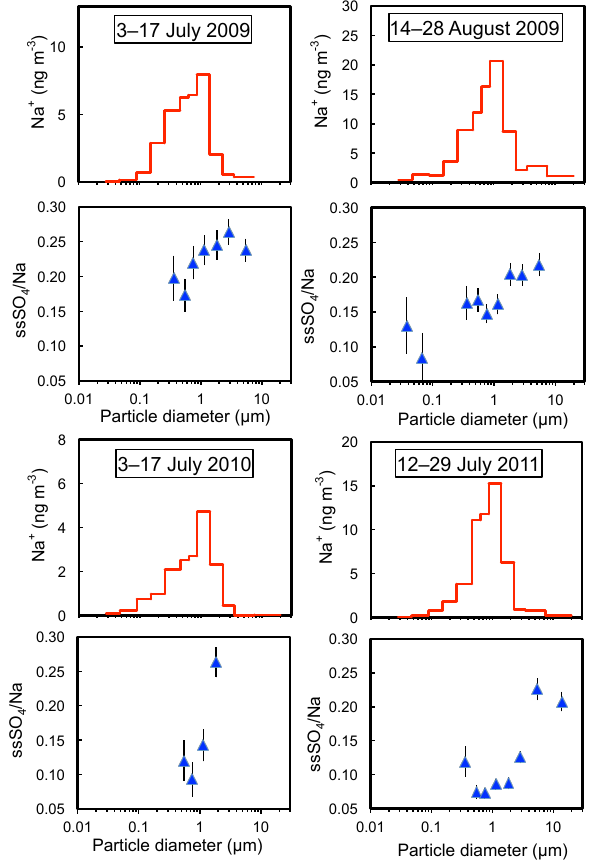
Figure 13. Size distribution of sodium and sea-salt sulfate to sodium ( R ) ratio in four winter aerosol samples collected at Con- cordia. The vertical bars refer to uncertainties in calculating R